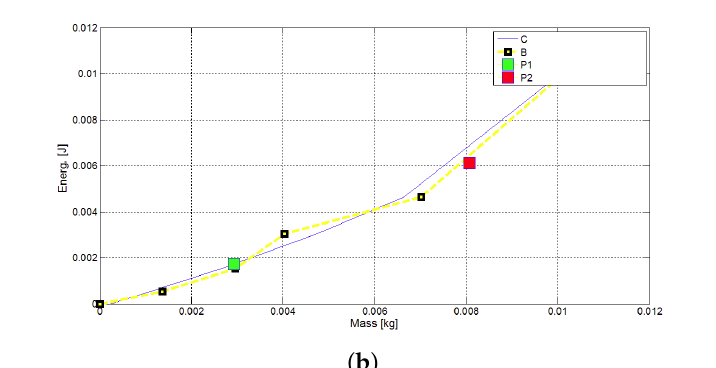
Figure 5. Bedload mass measurements with passive configuration in the nominal bandwidth of the impact ( < 14 KHz): ( a ) for each transducer type and ( b ) aggregated; B—steel balls in yellow, P1—3 g rock in green, P2—8 g rock in red, C—2nd-order polynomial fitting in